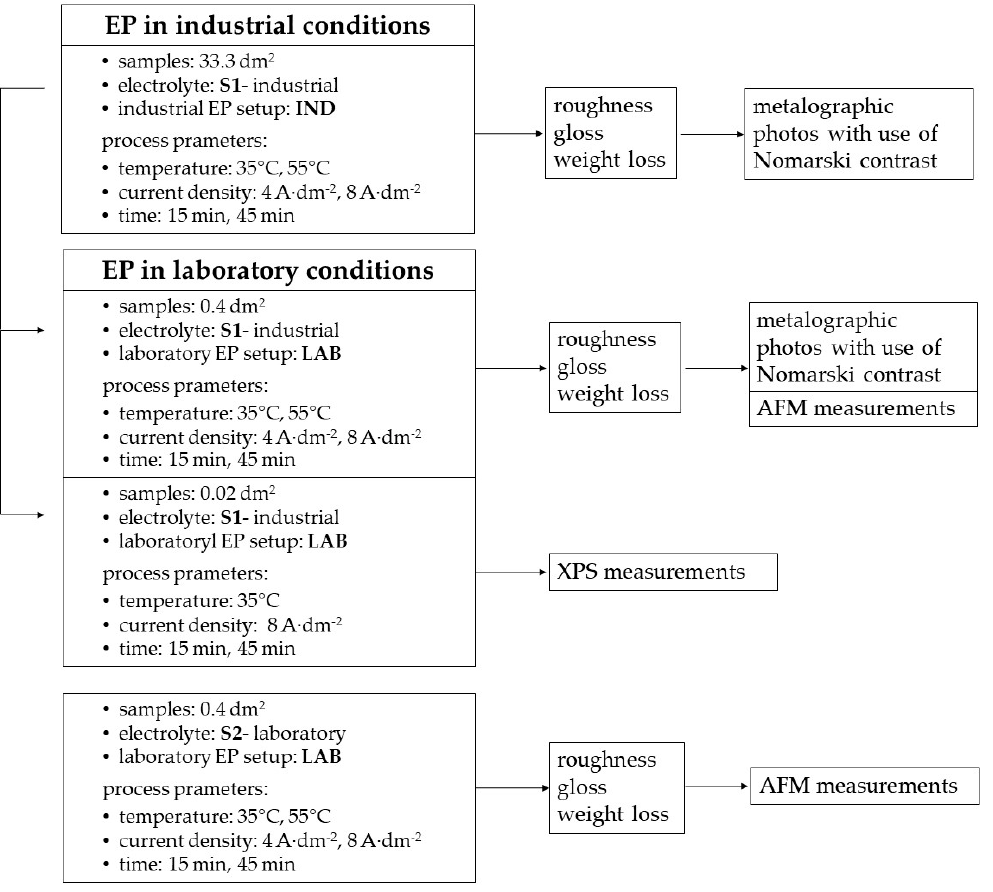
Figure 1. Experimental system.